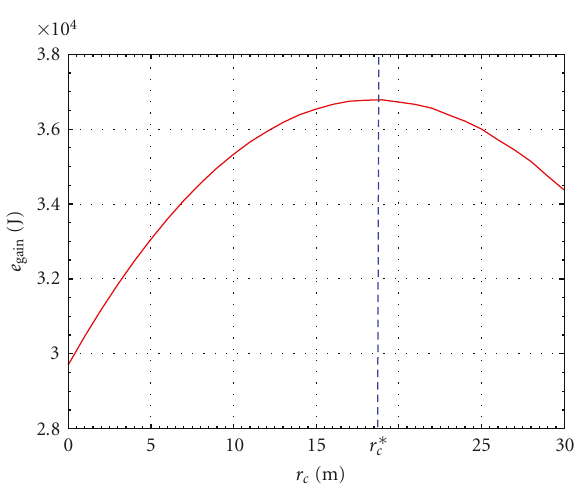
Figure 4: e gain is shown for a cluster of 500 sensor nodes with settings r s = 10 m., r t = 30m. (i.e., cluster range), n B = 16 bits and within the interval [0 − r t ] is ε = 0 . 2. The ideal correlator radius r ∗ c indicated with the dashed blue